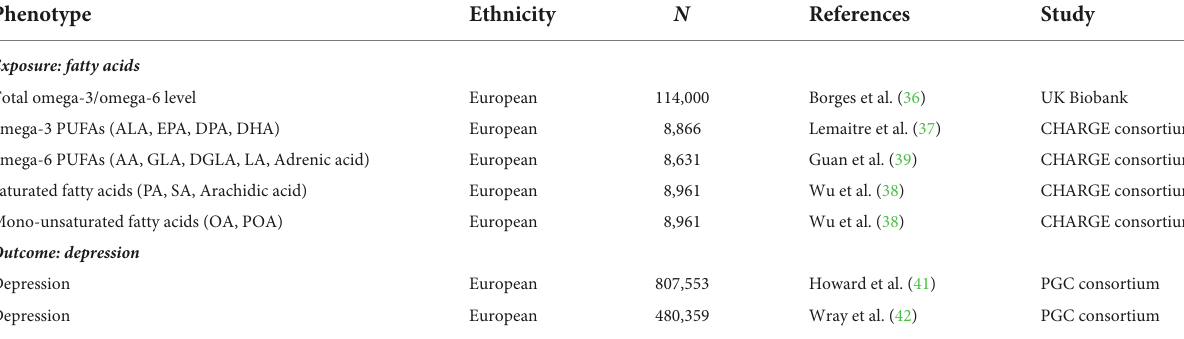
TABLE 1 Information of included genome-wide association studies (GWAS) studies and